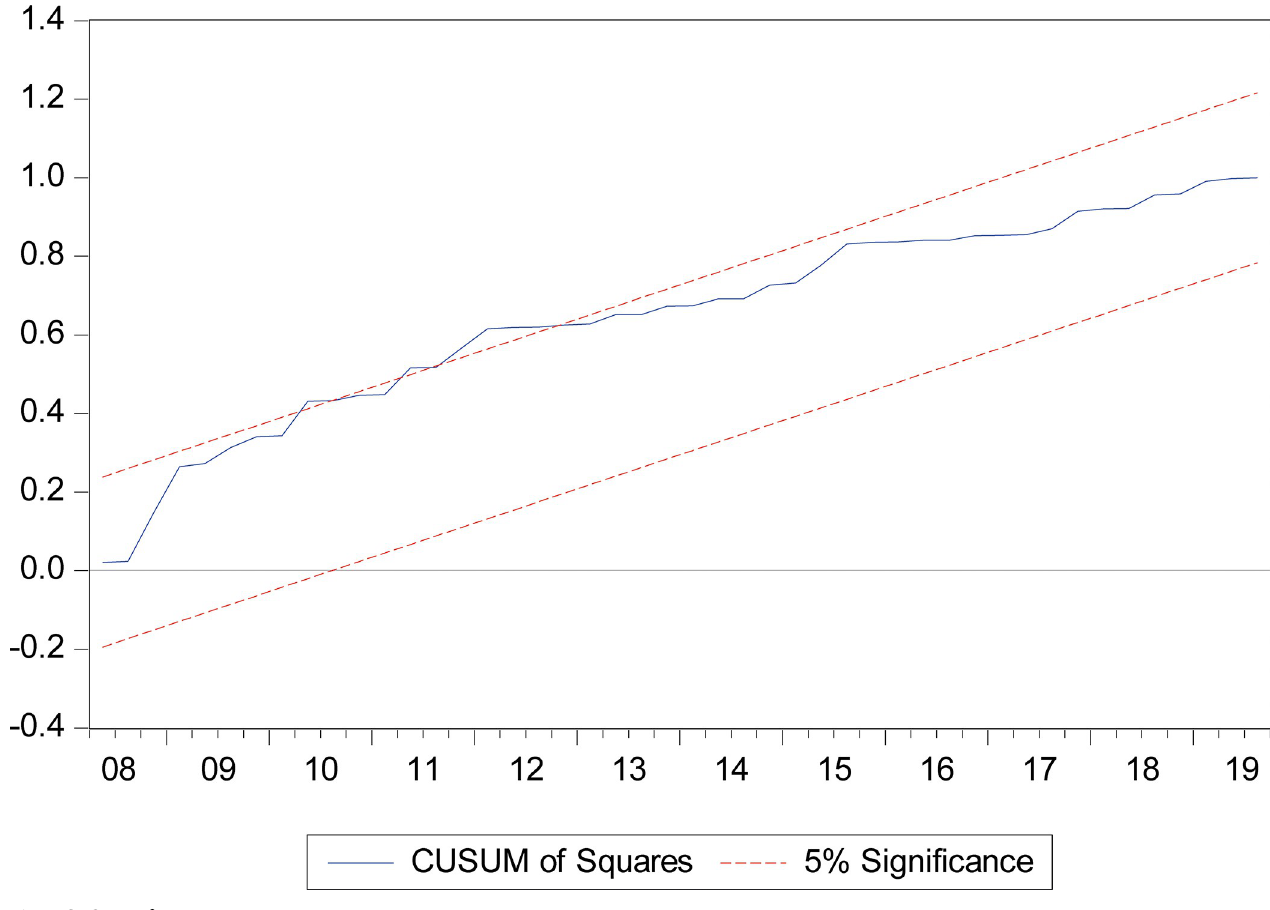
Fig 7. CUSUM of squares